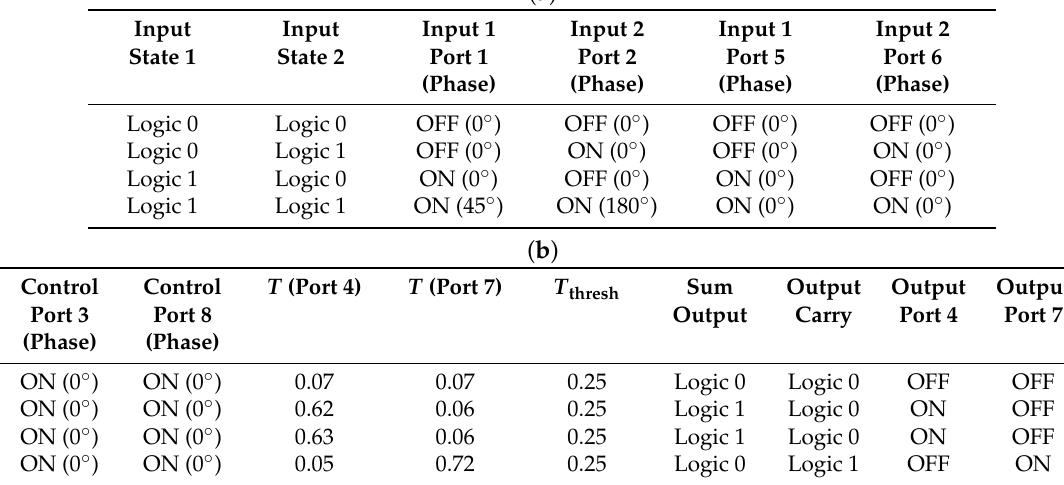
Table 1. Operation of the transmission for the proposed plasmonic